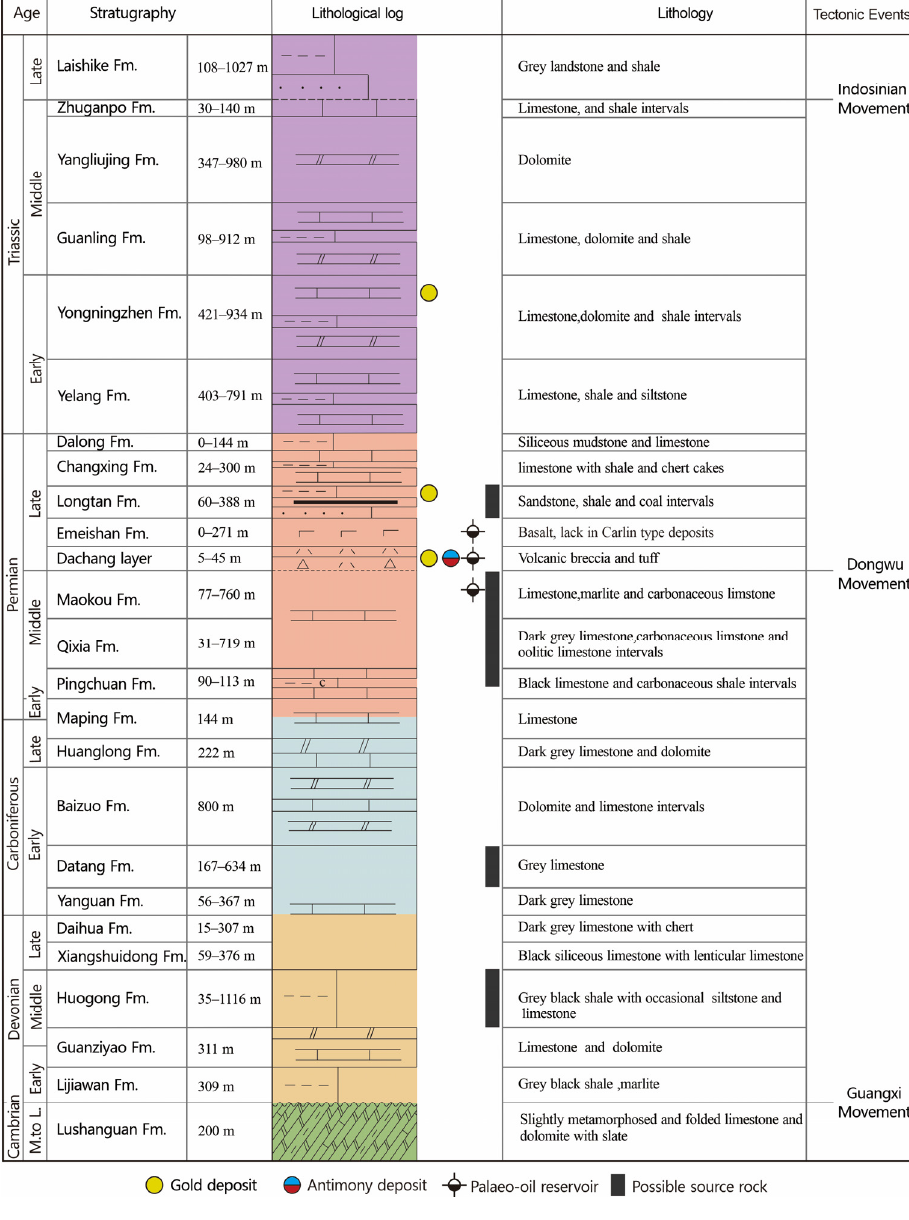
Figure 2. The stratigraphic sequences of central Southwestern Guizhou (modified after [42]). The strata exposed in the Qinglong antimony ore field are mainly Permian, including middle Permian Maokou Formation limestone (P 2 m ), “Danchang layer” (P 3 d ),